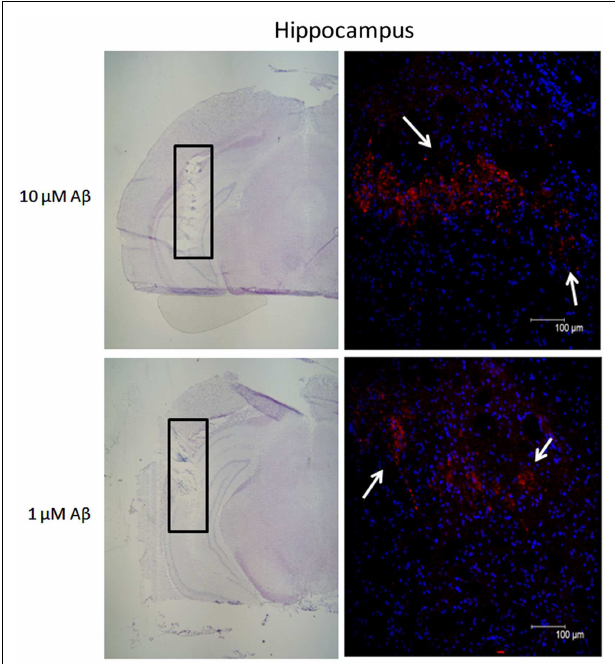
FIGURE 3 | Immunohistochemical analysis showing the presence of beta-amyloid (A β ) in hippocampal tissue after the perfusion of the peptide at two different concentrations. Coronal section indicating the location of the microdialysis probe (hippocampus, black rectangle) counterstained with Mayer Hematoxylin and relative fluorescence micrographs of the area within the black rectangle showing the presence of human A β protein. A β immunoreactivity (red-PE staining, white arrows) immediately after perfusion of 10 and 1 µ M A β 1–40. Nuclear DNA was counterstained with Hoechst 33,342 (blue staining). Scale bars for Mayer hematoxylin sections: 200 µ M. Scale bars for fluorescent micrographs: 100 µ